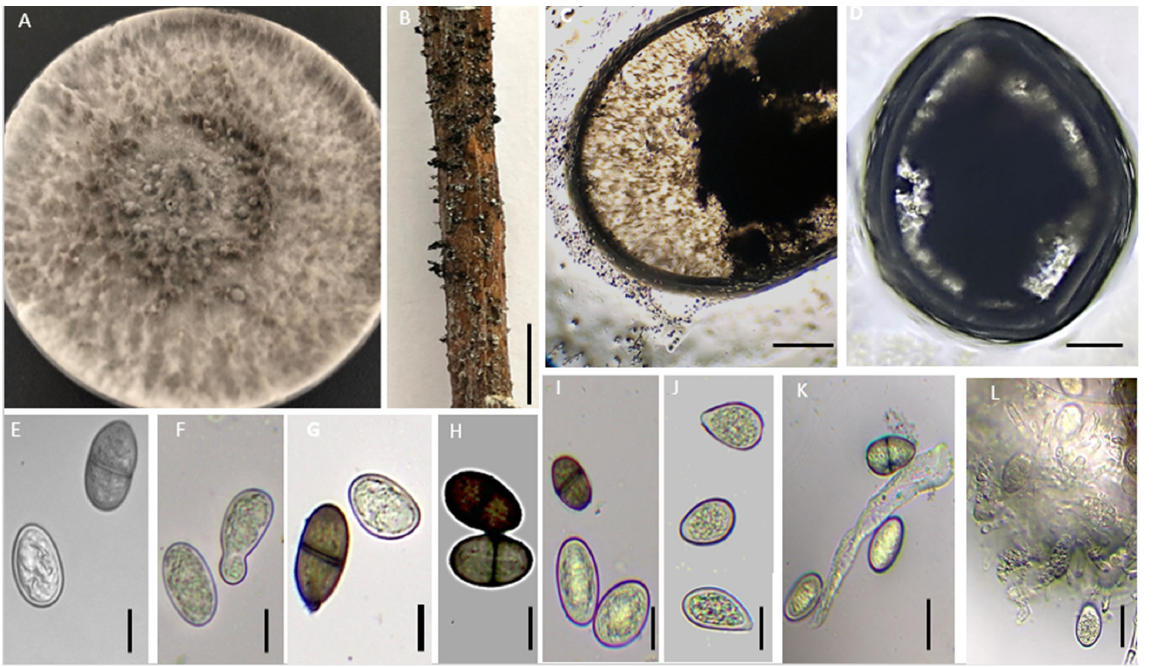
Figure 4. Morphological features of Lasiodiplodia theobromae . ( A ). Colony appearance and pycnidia formed at the surface; ( B ). Pycnidia on almond twig; ( C , D ). Section of pycnidium; ( E – J ). Conidia; ( K ). Conidiophore and conidia; ( L ). Conidia and conidiophores. Scale bar. ( B ) = 1 cm; ( C , D ) = 100 μ m; ( E – H ) = 10 μ m; ( I – L ) = 10 μ m.